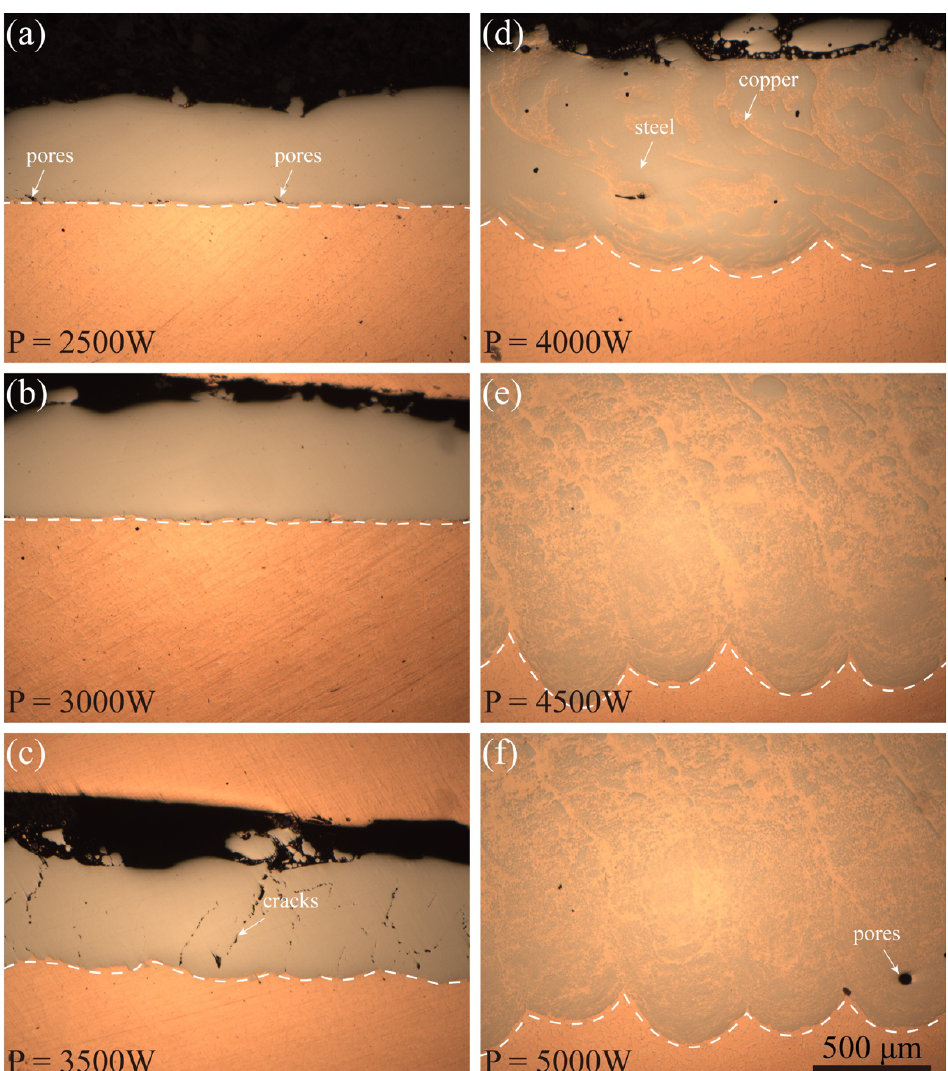
Figure 13. Cross-section morphologies of the single-layer specimens at different laser power: ( a ) P = 2500 W, ( b ) P = 3000 W, ( c ) P = 3500 W, ( d ) P = 4000 W, ( e ) P = 4500 W, and ( f ) P = 5000 W.